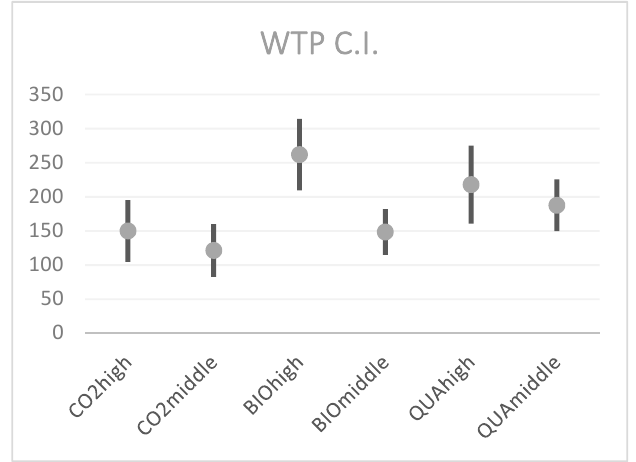
Figure 1. WTP Confidence Intervals (CIs).